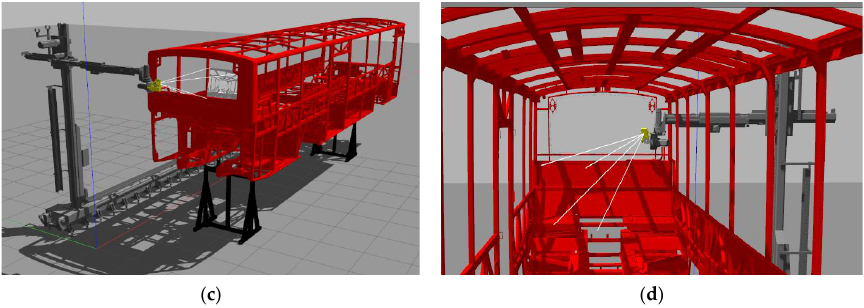
Figure 10. System description: ( a ) a photo of the ROKOS, ( b – d ) demonstration of the simulated environment with SRVT.